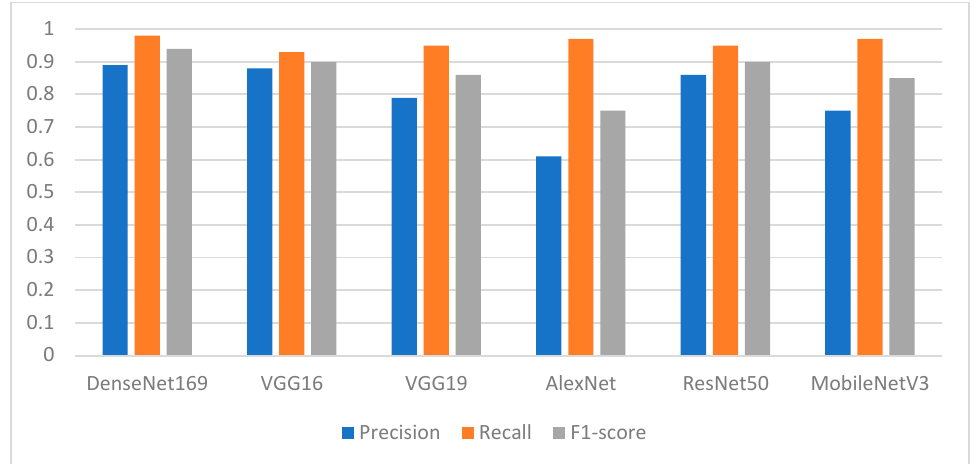
Figure 9. Performance of the models in terms of precision, recall, and F1-score with respect to class 1 (missing teeth class).